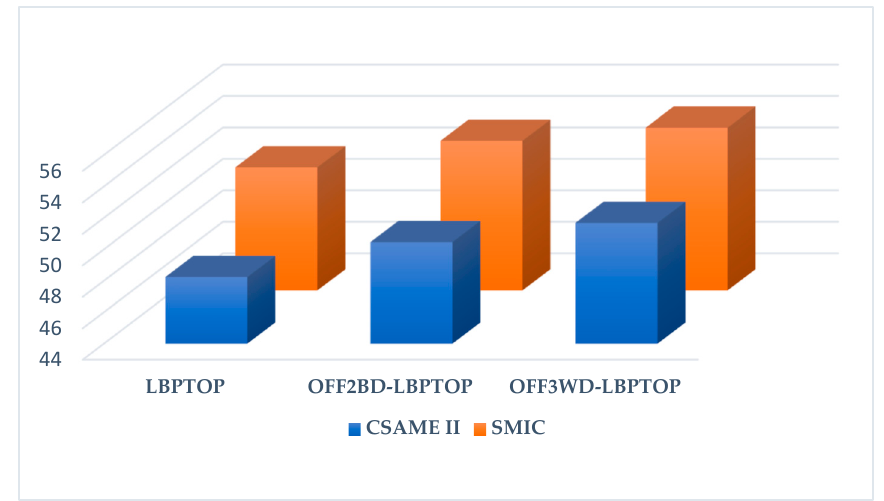
Figure 6. Recognition accuracies of different algorithms .